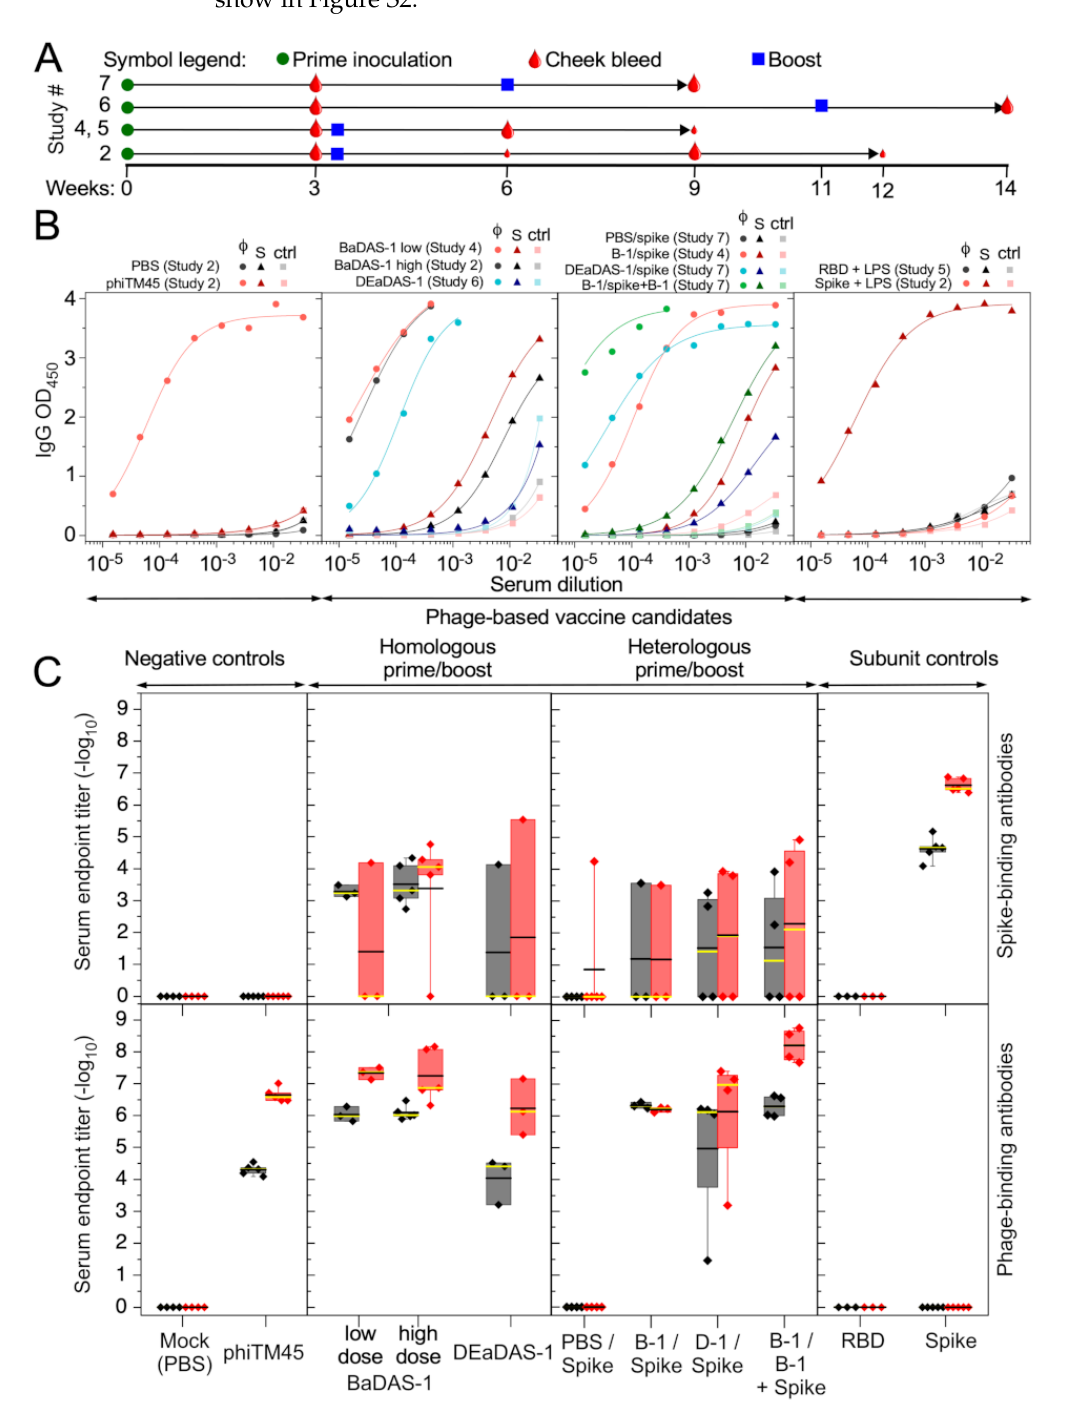
Figure 5. Immune responses of mice to effective phage-based vaccine candidates and controls. ( A ) Timelines for the subset of vaccination studies shown in this figure (timelines and additional study details are also included in Table 2). Each study begins with a prime inoculation (green circle) and was followed by a cheek bleed (red drop) at Week 3, but subsequent boost (blue square) and bleed schedules differed between studies as indicated. Large red drops indicate cheek bleeds for which corresponding data are shown in panels B and C, while ELISA data for cheek bleeds indicated with small red drops are not shown here. ( B ) IgG ELISA curves for phage-coated ( ϕ ), spike-coated (S), and uncoated (ctrl) wells are shown for a selection of responsive animals immunized with recombinant phages and control samples. The Study # for each dataset is indicated above each panel. BaDAS-1 and DEaDAS-1 (central two panels) both induce strong IgG responses to the